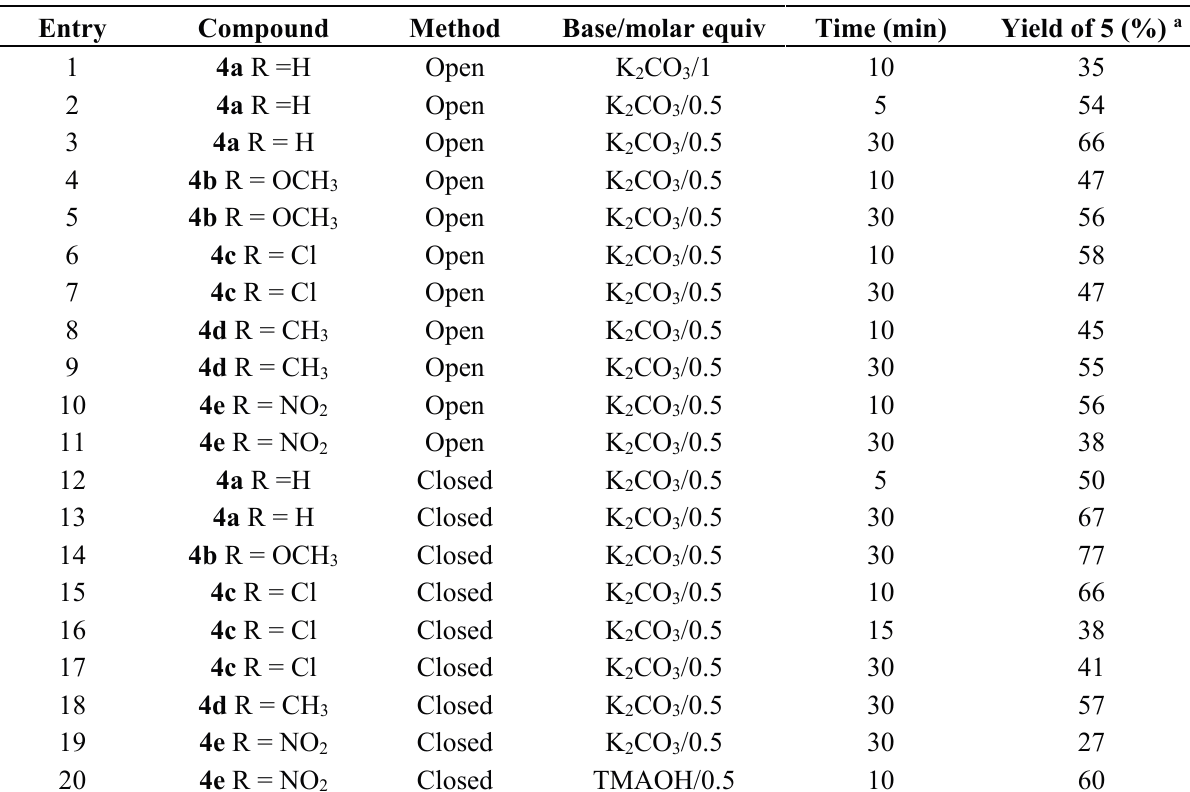
Table 2. Cyclodehydration of 5-aryl-1-(2-hydroxyphenyl)pent-4-ene-1,3-diones 4a – e to ( E )-2-styrylchromones 5a – e in water, under microwave irradiation, using open vessel reflux and closed vessel (120 °C)